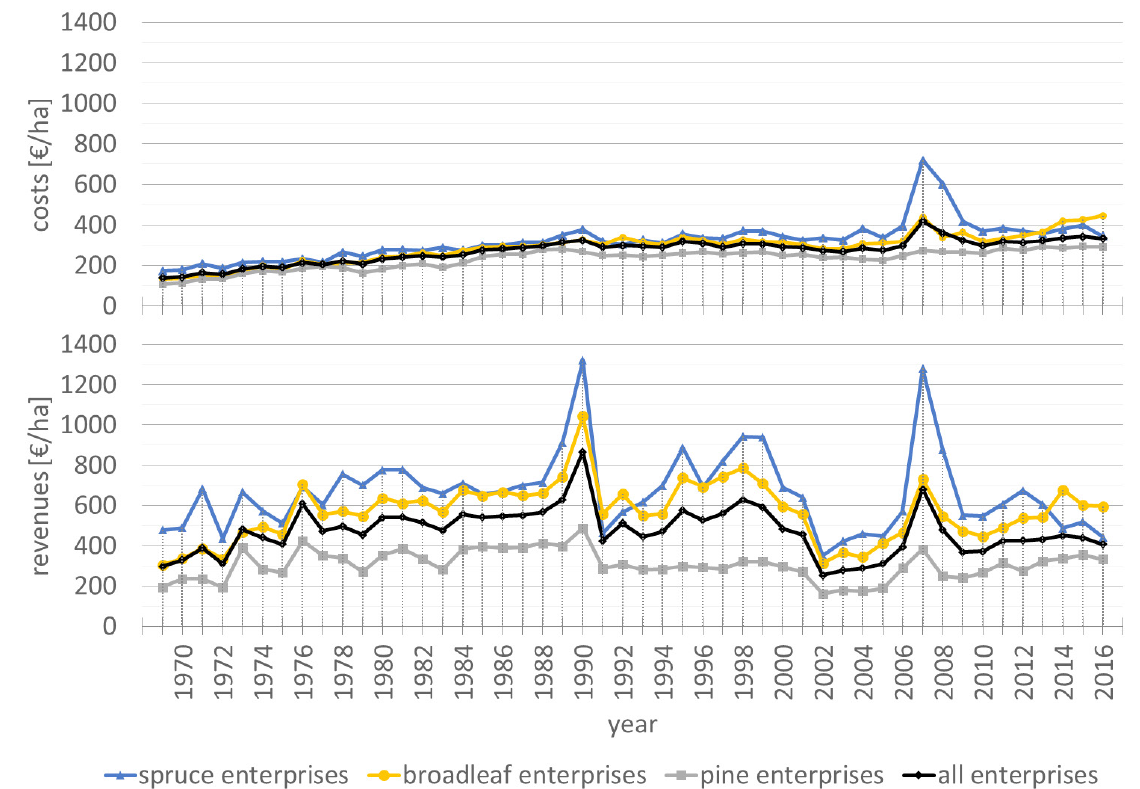
Figure 2: Costs and revenues per hectare forest land according to consultancy